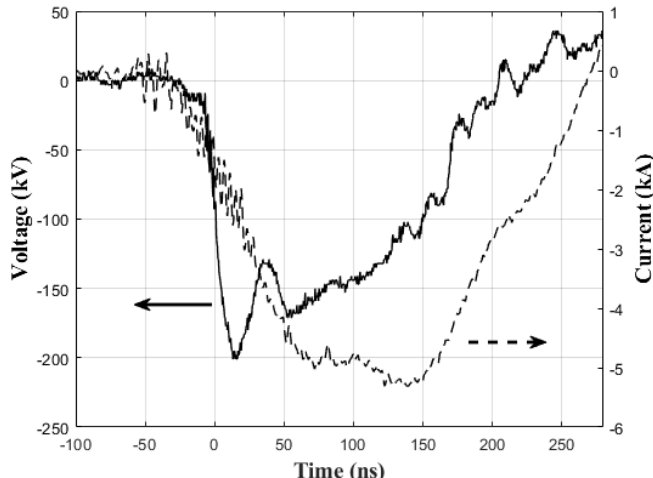
Figure 3. Typical output waveform of the diode voltage and diode current applied to the proposed coaxial vircator (D AK = 6 mm).